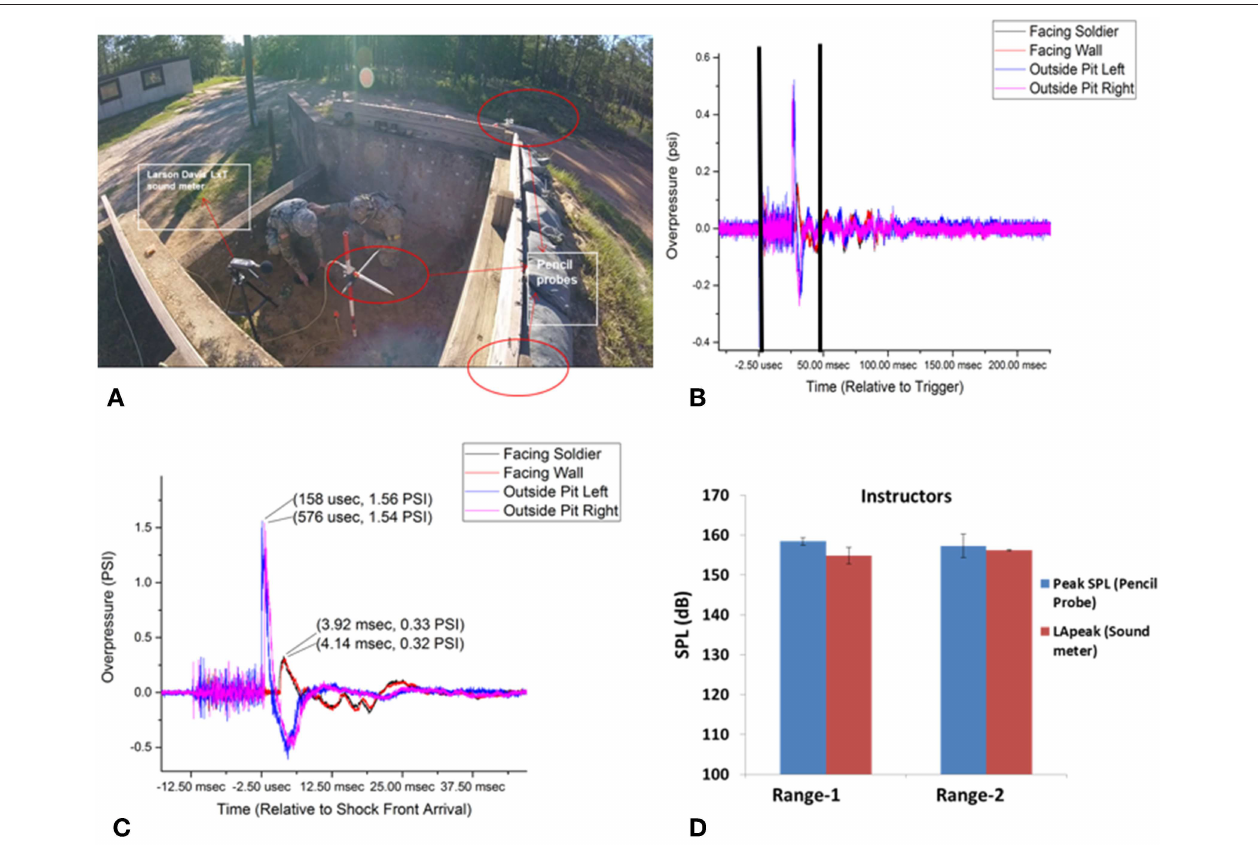
FIGURE 1 | (A) Showing the instrumentation location inside a pit of range-1. (B) Pencil probes recording of the pressure at different locations of range-1. (C) Zoomed in version (area of the black bars in panel B ) of the oncoming pressure wave recorded at different locations in the grenade pit of range-1. (D) Sound pressures recorded in range-1 and range-2 of sound meter and pencil probes, no significant differences were observed when both sensors types are